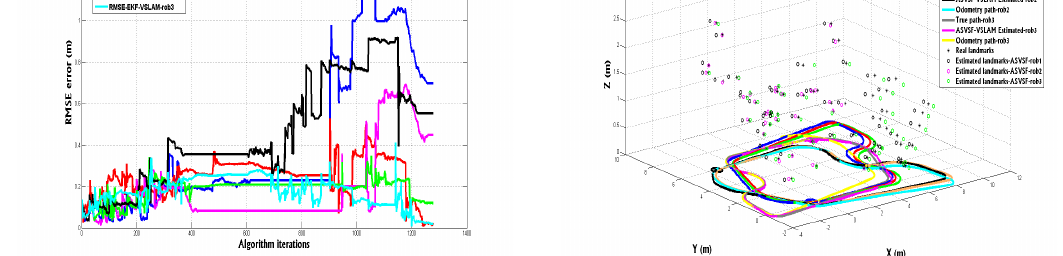
Fig. 7: RMSE Results with white centered Gaussian noise.